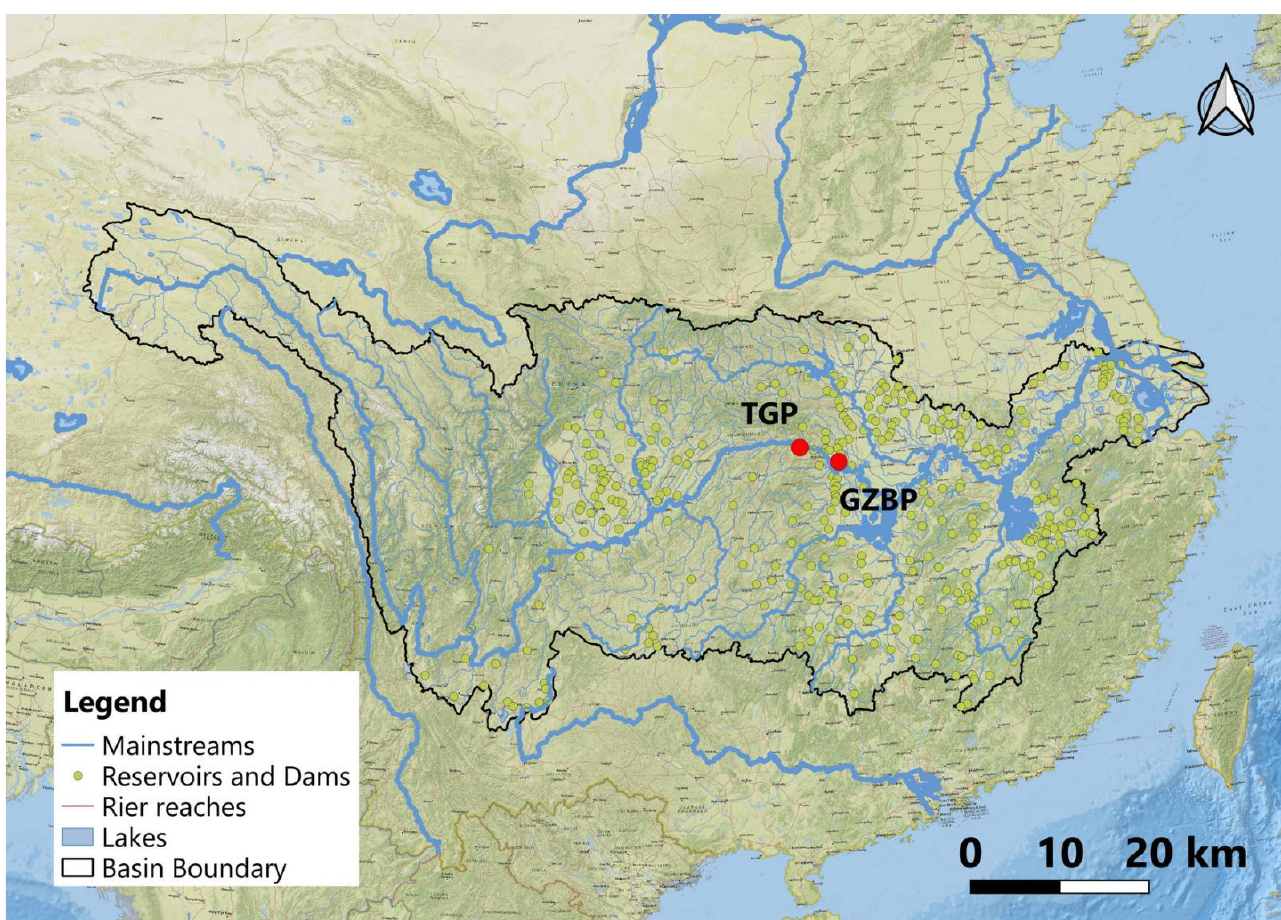
Figure 2. Yangtze river basin and cascade GZBP and TGP location.